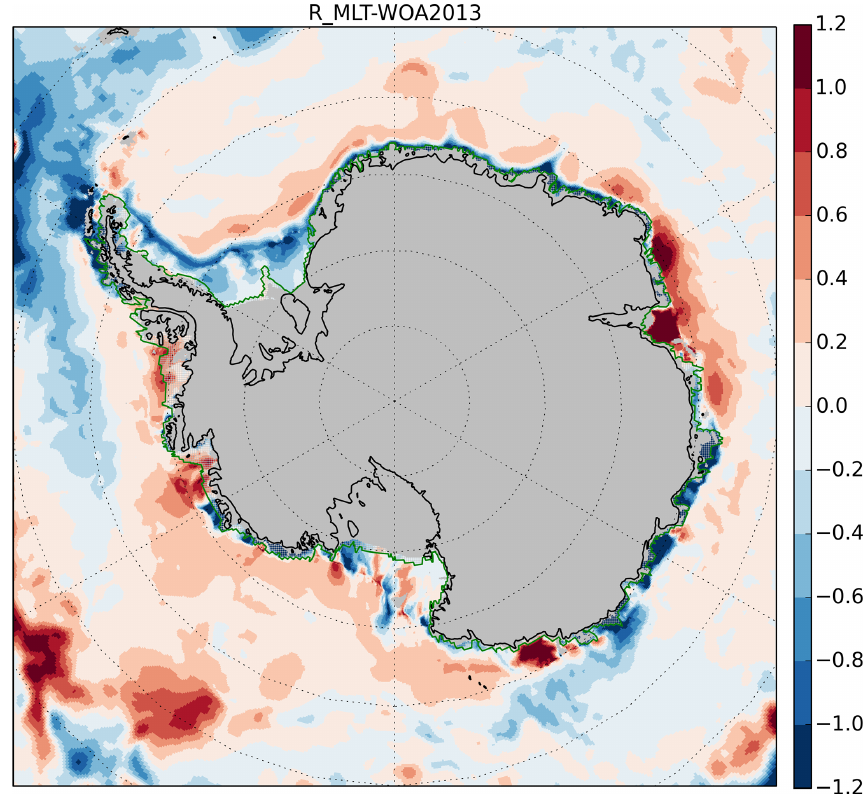
Figure 14. Shown are 300–1000m mean temperature differences between R_MLT (year 10, 1988) and observations from World Ocean Atlas 2013 (Locarnini et al., 2013; Zweng et al., 2013). Grey area represents ice sheet, ice shelves or ocean shallower than 300m. The hatched area limited by the green line represents where the observational dataset is obtained by